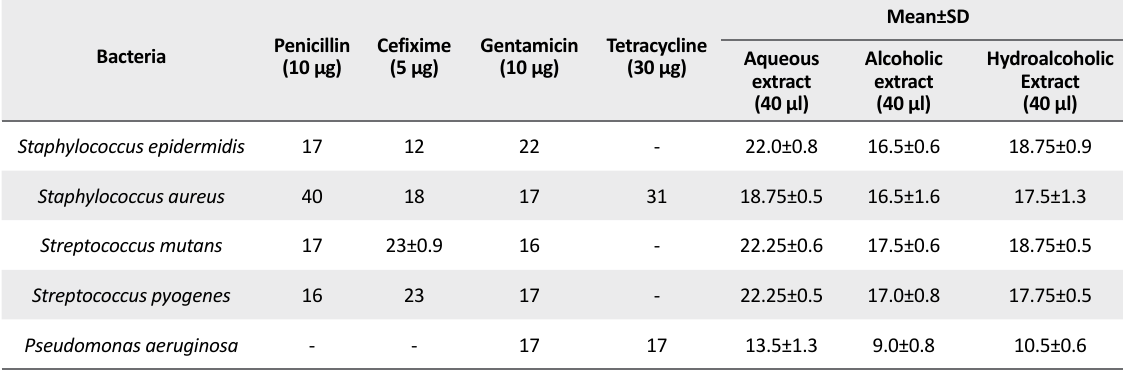
Table 1. Mean diameter of growth inhibition zone (mL) of Morus nigra extracts and standard antibiotics for different bacteria